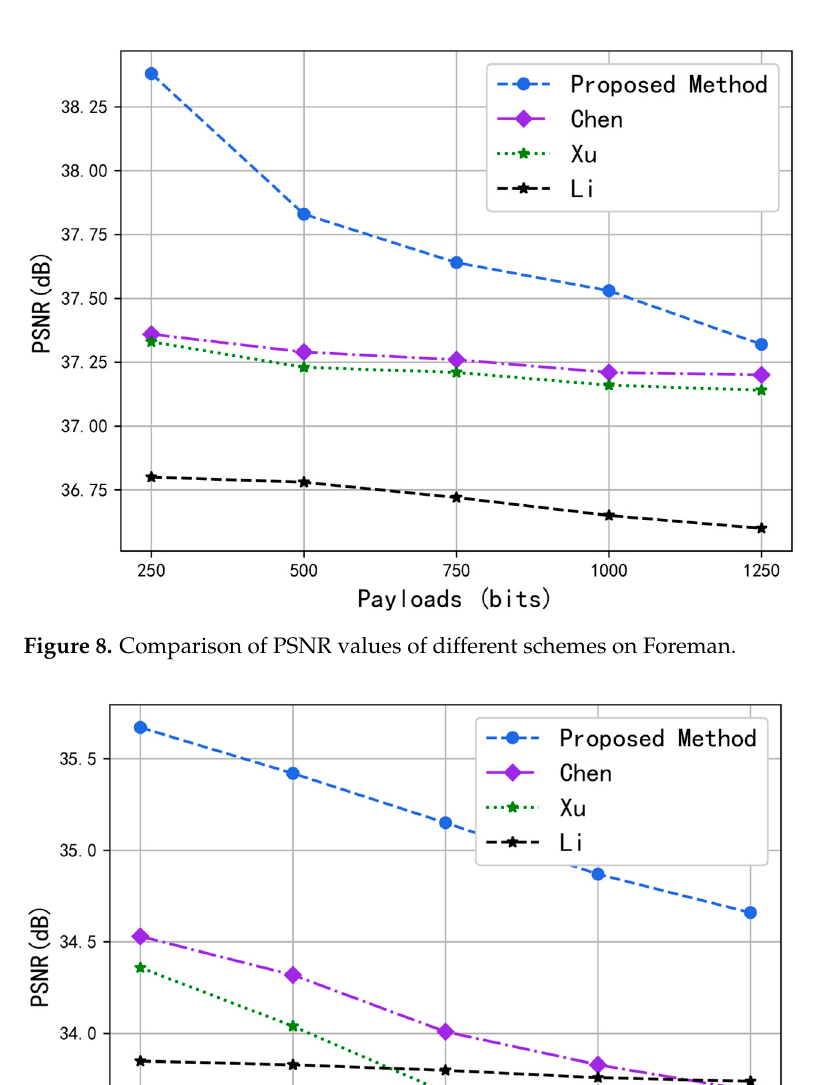
Figure 7. Comparison of PSNR values of different schemes on Container.